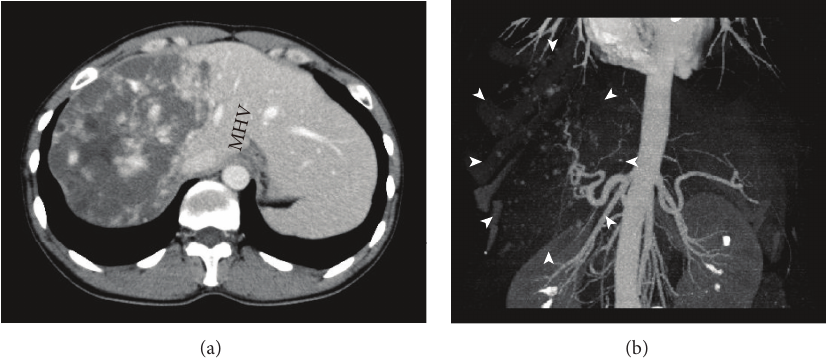
Figure 1: Multidetector computed tomography (MDCT) images. (a) Axial MDCT image shows a huge hypodense mass in the right lobe of the liver measuring about 17 cm, extending to the middle hepatic vein (MHV). (b) Vascular reconstruction image shows “cotton wool-like pooling” (arrowhead).